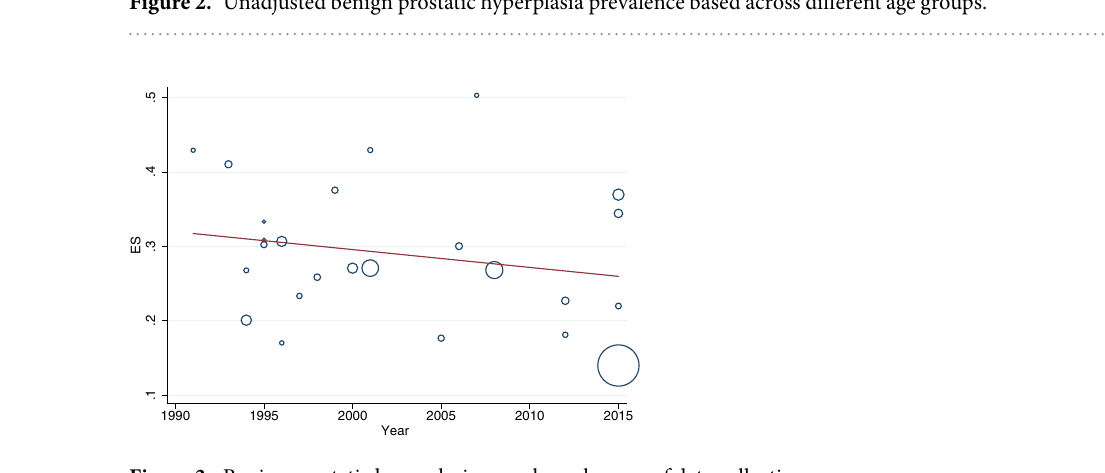
Figure 3. Benign prostatic hyperplasia prevalence by year of data